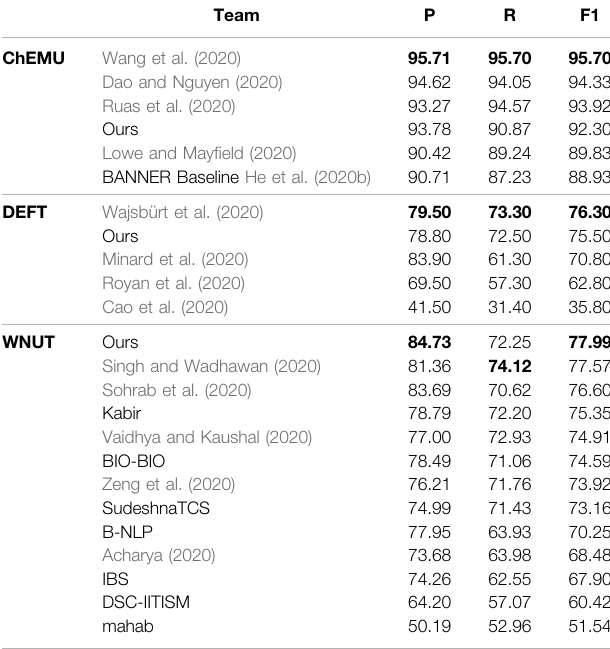
TABLE 7 | Test phase results of the ensemble model compared to other participants for datasets of ChEMU, DEFT, and WNUT